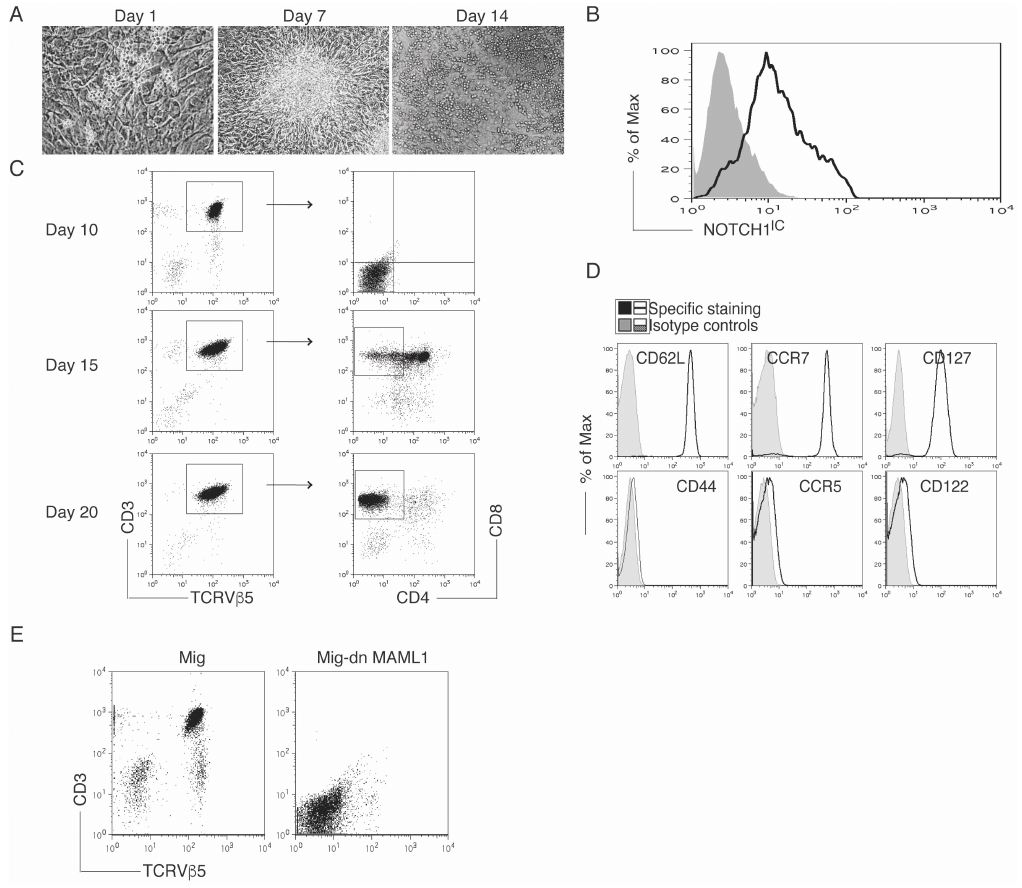
Figure 1. Notch signaling induces hematopoietic stem cells (HSC)-T cell differentiation. Bone marrow–derived CD117 + HSCs from OT-I TCR transgenic mice were either transduced with a Mig or Mig-dnMAML1, and then directly co-cultured with OP9-DLL1/DLL4 cells and cytokines (inteleukin-7 (IL-7) and FMS-like tyrosine kinase 3 ligand (Flt3L)). ( A ) Morphology of cell differentiation on days 0, 7, and 14; ( B ) On day 3, cleaved Notch1 intracellular domain (Notch1 IC ) (open histogram) was determined by intracellular staining of HSC-derived cells (filled histogram shows isotype control); ( C ) Differentiation of HSC-T cells in vitro. Flow cytometric analysis for the protein expression of HSC-derived cells on days 10, 15 and 20. CD3 + TCRV β 5 + cells were gated as indicated, and analyzed for expression of CD4 and CD8; ( D ) Phenotypic analysis of HSC-T cells. At day 20, CD3 + TCR β 5 + CD8 + T cells were analyzed by flow cytometry for expression of certain markers; ( E ) Dominant-negative (DN) MAML1 blocked the in vitro HSC-T cell differentiation. On day 10, live HSC-derived cells were analyzed for expression of CD3 + TCRV β 5 + cells by flow cytometry. Data are the representative of three independent experiments.